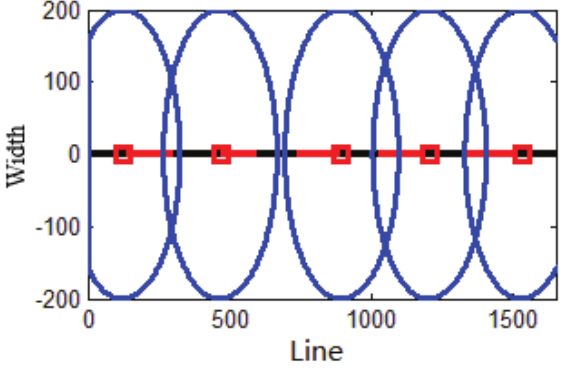
Figure 15: Case 2: The optimal line tunnels by ECO algorithm (L =